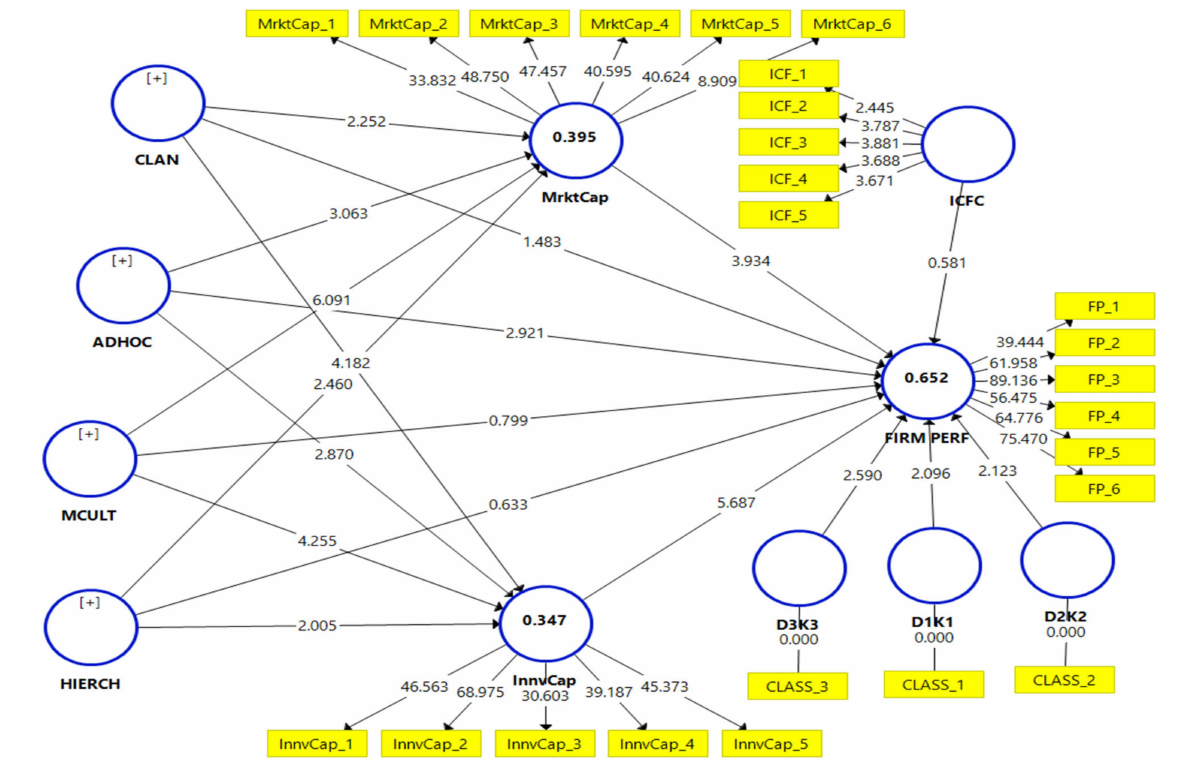
Figure 3. Full Structural model of OC types, FC dimensions and firm performance.